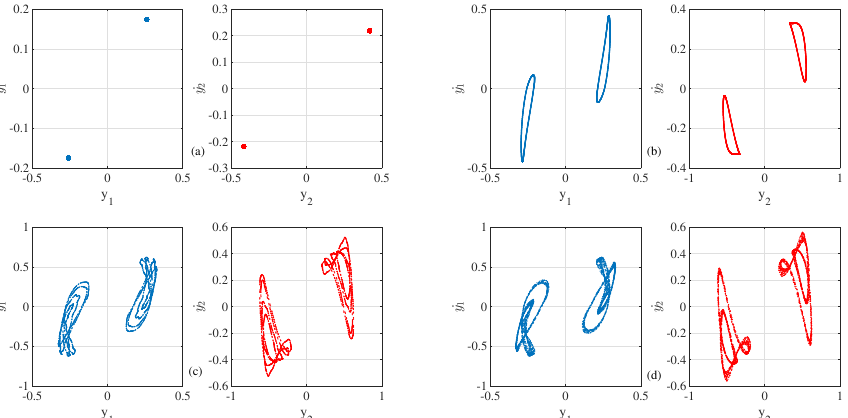
Figure 8. Poincaré sections of the considered system for different values of ω nd . x -axis is the non- dimensional displacements y 1 , y 2 and the y -axis is the non-dimensional velocities ˙ y 1 , ˙ y 2 , respectively. The left (blue color) and the right (red color) sides of each figure are the poincaré sections of each oscillator. ( a ) ω nd = 4.00, Period-1 orbit, ( b ) ω nd = 4.05, quasi-periodic orbit, ( c ) ω nd = 4.093, quasi-periodic orbit, ( d ) ω nd = 4.098, chaotic orbit. The parameters are: ζ 1 = 0.0868, ζ 2 = 0.1036, t 1 = 0.2413, t 2 = 0.288, b 1 = 45.7143, b 2 = 54.5737, a 1 = 5.8548 × 10 − 3 , D 1 = 1.5, β = 11.11, µ = 1.1938, δ 1 = 1. The initial condition is chosen to ( 0.333,0,0,0 ) . (Color